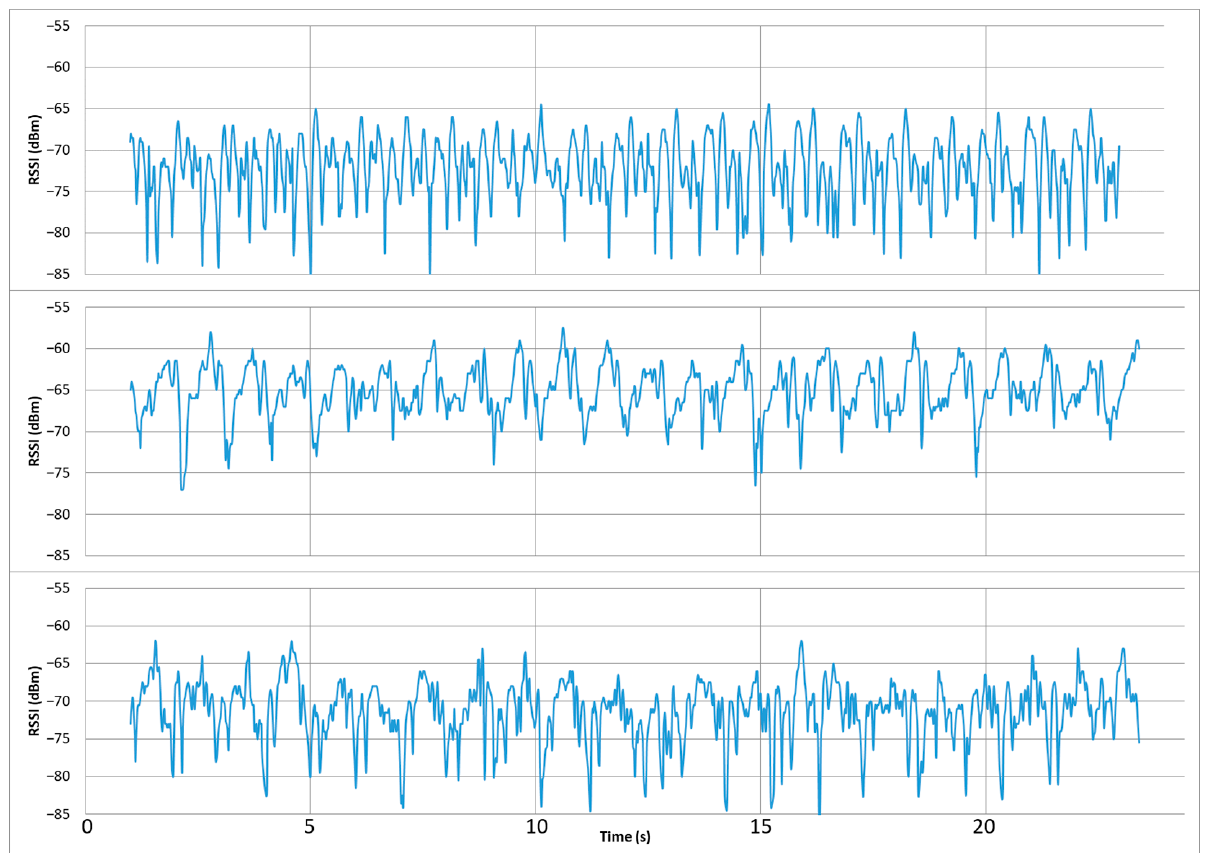
Figure 15. RSSI variation with time in the walking scenario for the three subjects on the 868 MHz band for − 2 dBm of transmit power and with the sender node located on the right ankle: ( top ) Subject A, ( middle ) Subject B, ( bottom ) Subject C.